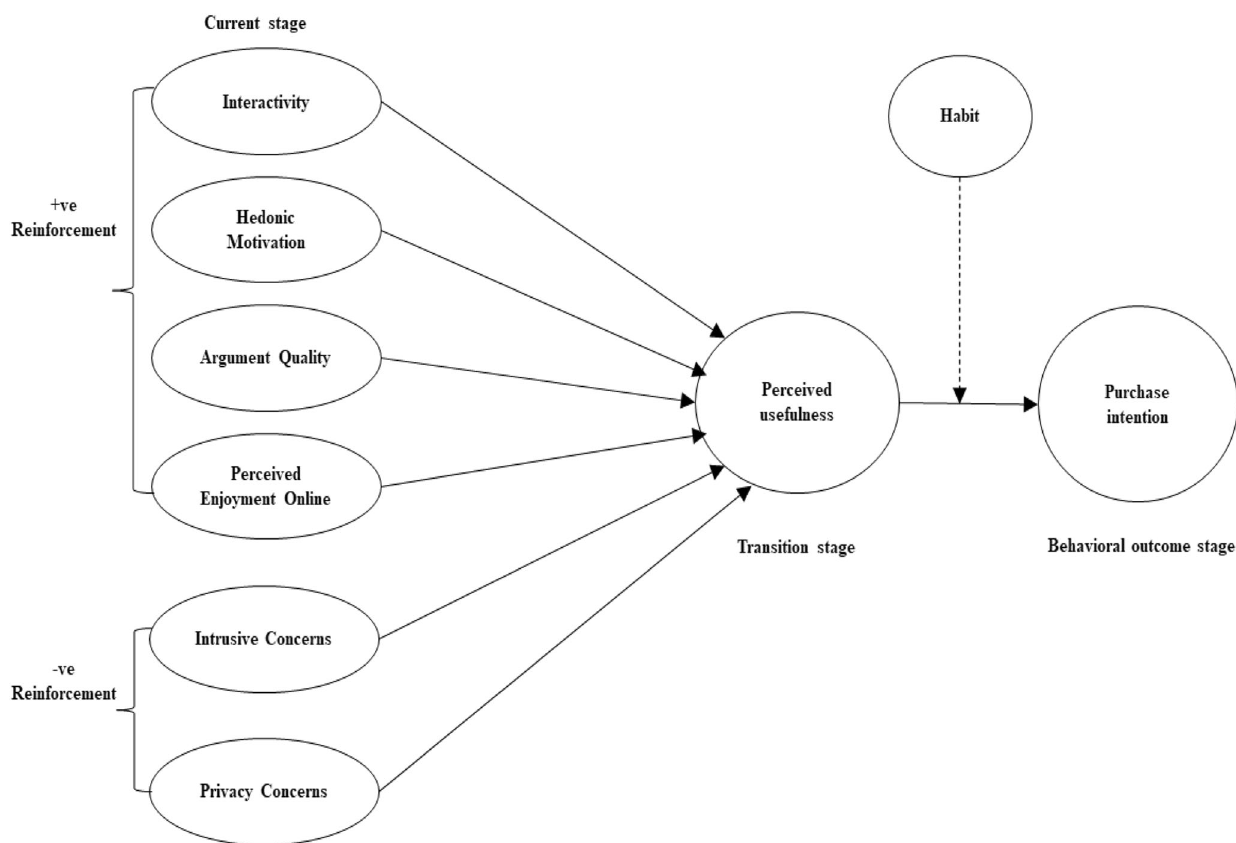
Fig. 1 Research model between digital communication drivers and purchase